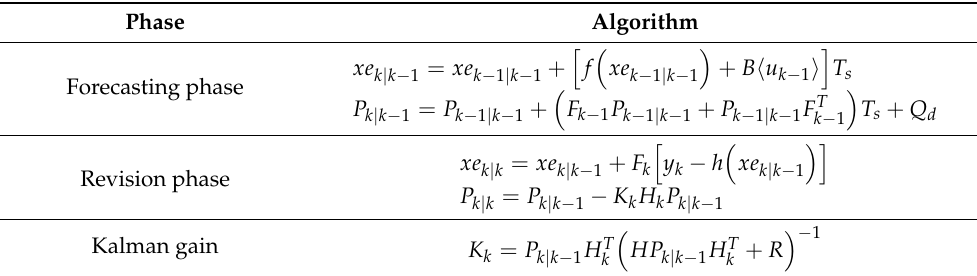
Table 5. EKF algorithm. Phase Algorithm Forecasting